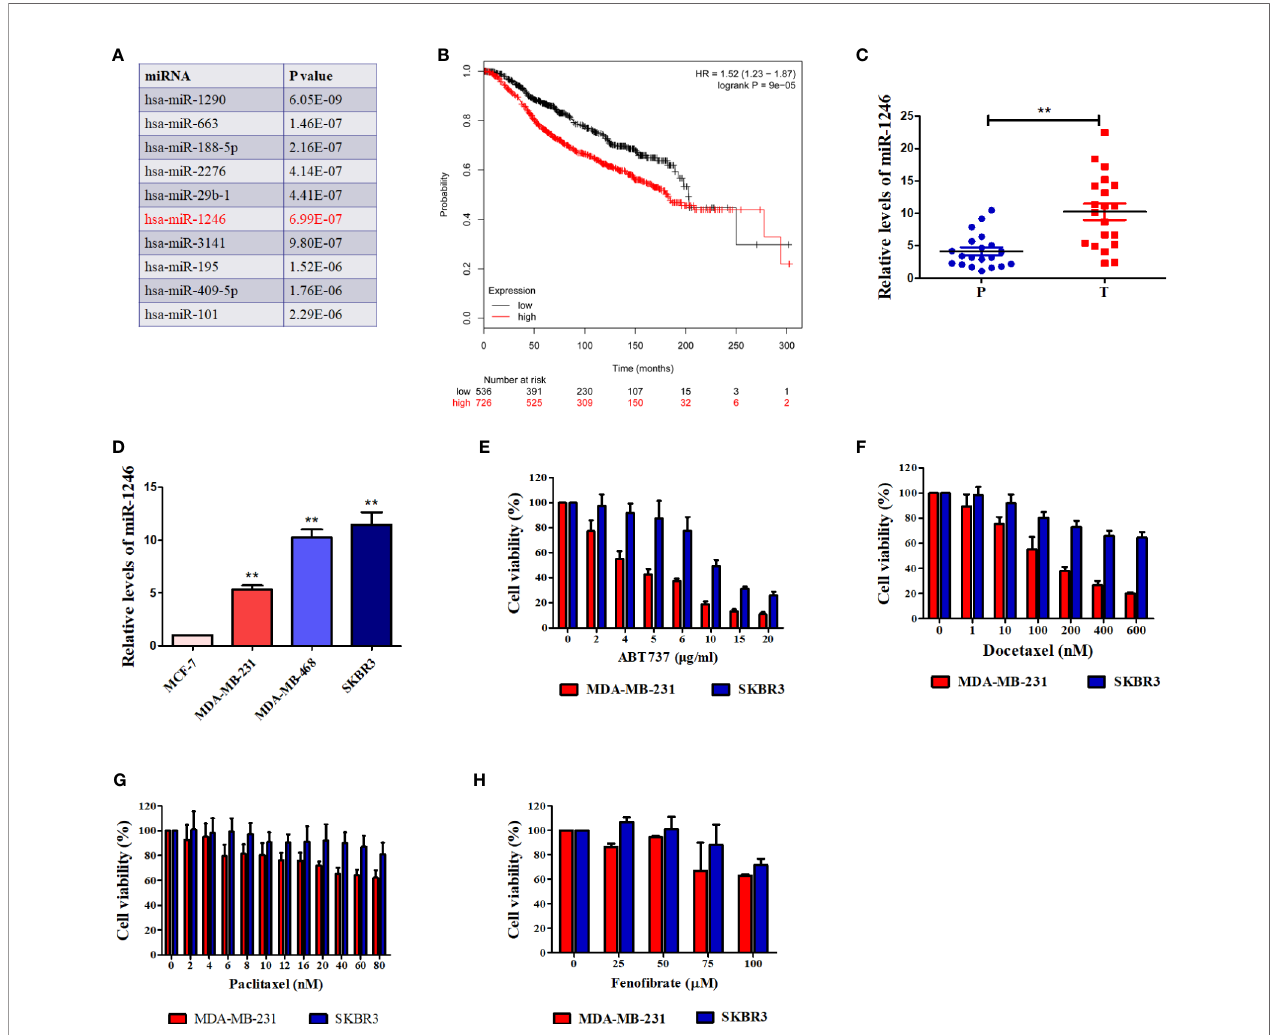
FIGURE 1 | miR-1246 is correlated with survival of breast cancer patients and drug resistance of breast cancer cells. (A) Top 10 miRNAs were listed according to their signi fi cance of correlating with overall breast cancer patient survival. (B) Correlation between expression of miR-1246 and overall survival of breast cancer patients. Data were obtained from the Kaplan Meier Plotter. (C) miR-1246 levels in 20 paired human breast cancer tissues and paracancerous tissues were determined by RT-qPCR. P, paracancerous tissues; C, breast cancer tissues. (D) miR-1246 levels expressed in human breast cancer cell lines were examined by RT-qPCR. (E to H) The cytotoxicity of ABT-737 (E) , Paclitaxel (F) , Docetaxel (G) and Feno fi brate (H) in the indicated cells were determined by MTT analysis. Data are presented as mean ± SD, n=3. **P < 0.01 vs.